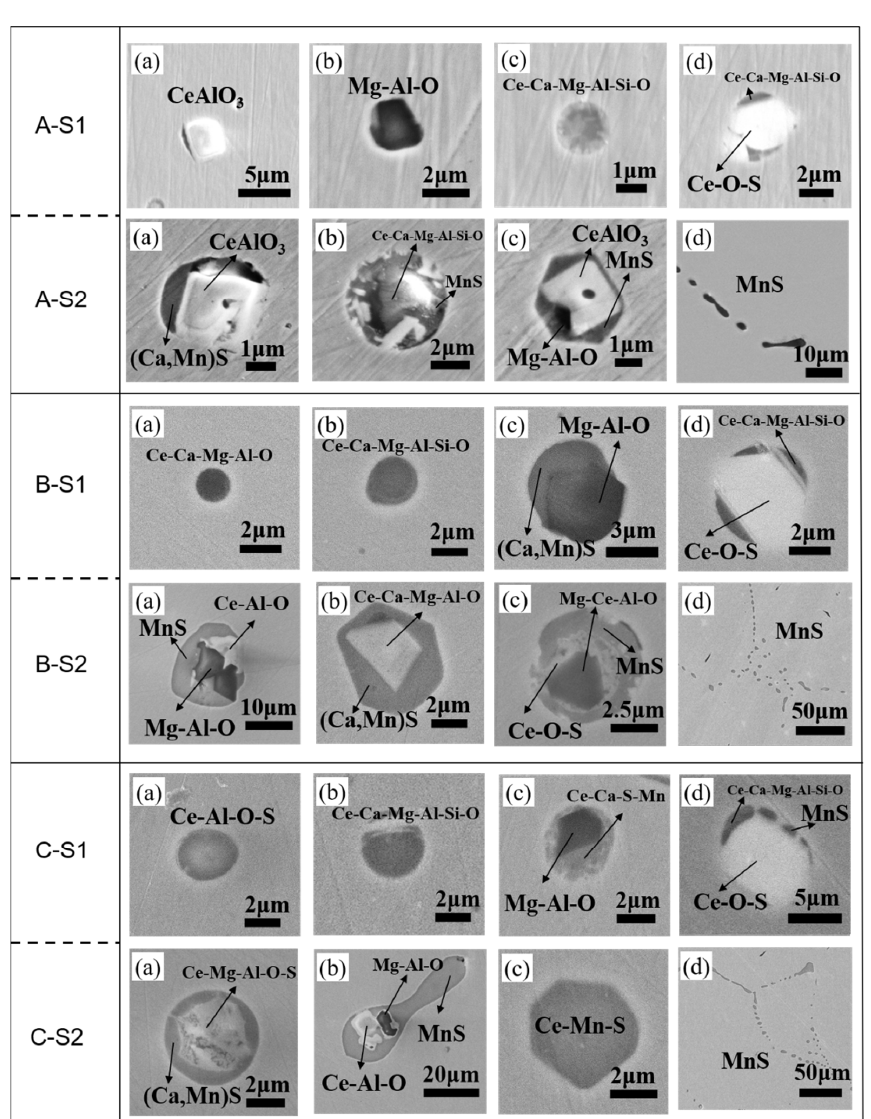
Figure 5. Typical morphology and classification of the inclusions observed in S1–S2 sample. A-S1-( a )– A-S1-( d ) Inclusion in A-S1. A-S2-( a )–A-S2-( d ) Inclusion in A-S2. B-S1-( a )–B-S1-( d ) Inclusion in B-S1. B-S2-( a )–B-S2-( d ) Inclusion in B-S2. C-S1-( a )–C-S1-( d ) Inclusion in C-S1. C-S2-( a )–C-S2-( d ) Inclusion in